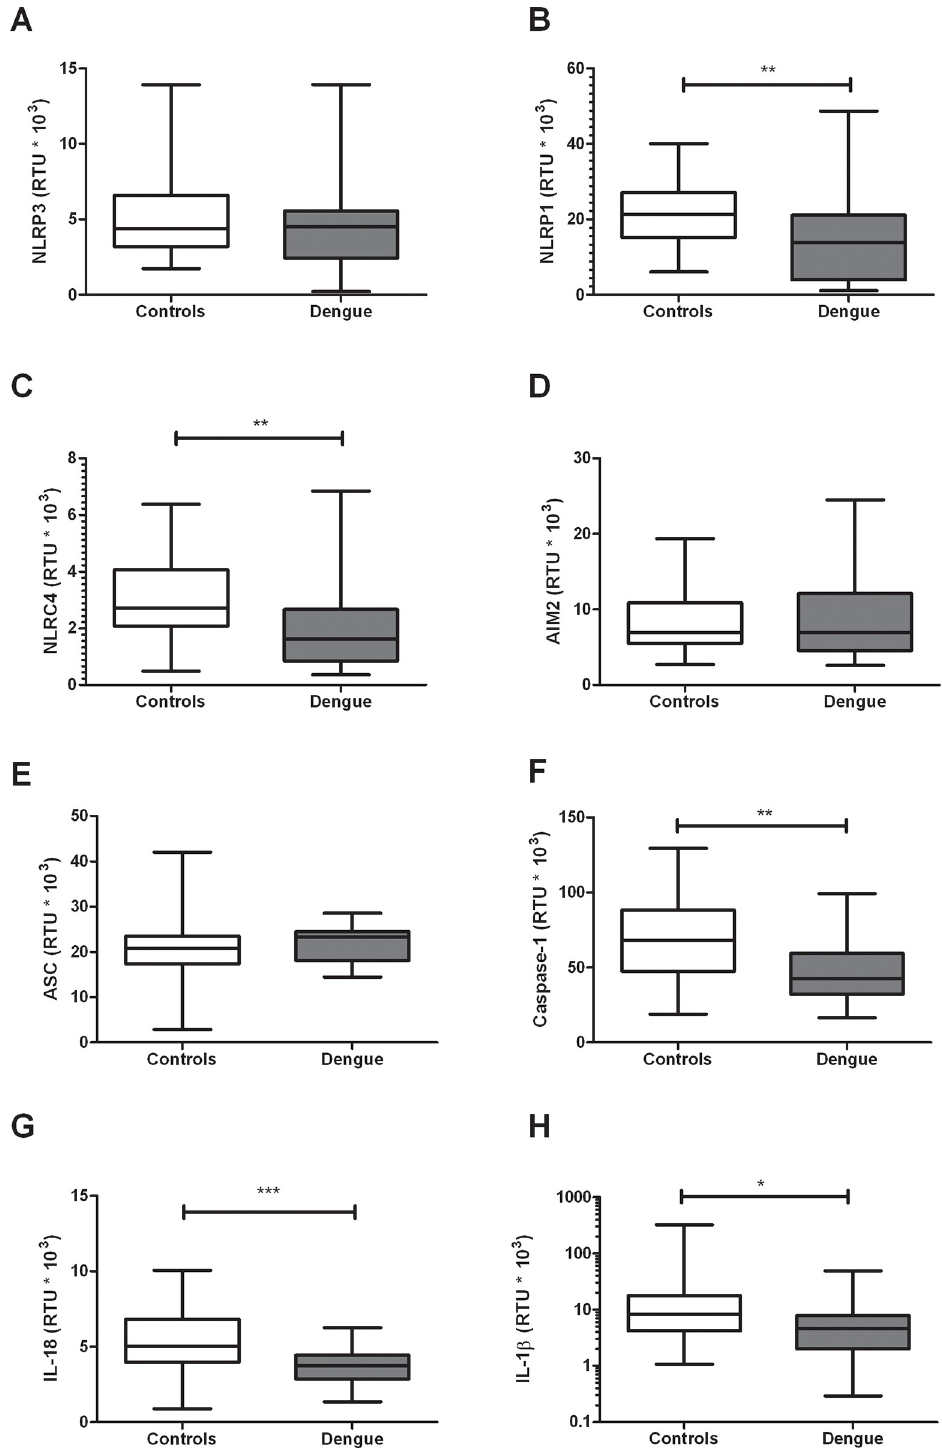
Fig 3. Inflammasome-related genes expression in dengue patients. The expression of (A) NLRP3, (B) NLRP1, (C) NLRC4, (D) AIM2, (E) ASC, (F) caspase-1, (G) IL-18 and (H) IL-1 β was evaluated by real time PCR in PBMCs (by duplicates) from dengue patients and healthy controls. The β -actin gene was used as a constituent gene to normalize the RNA content. The results are presented as medians with maximum and minimum values (box and whisker plot). Statistical comparison was made using the Mann-Whitney U tests with a confidence level of 95%. Significant differences are represented at the top of the figure ( � p < 0.05, �� p < 0.01; ��� p < 0.001).